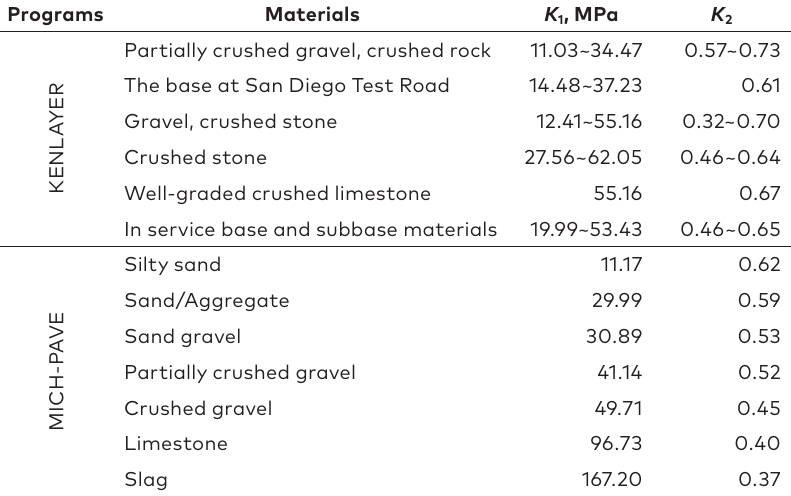
Table 1. The values of K 1 and K 2 for some typical granular materials